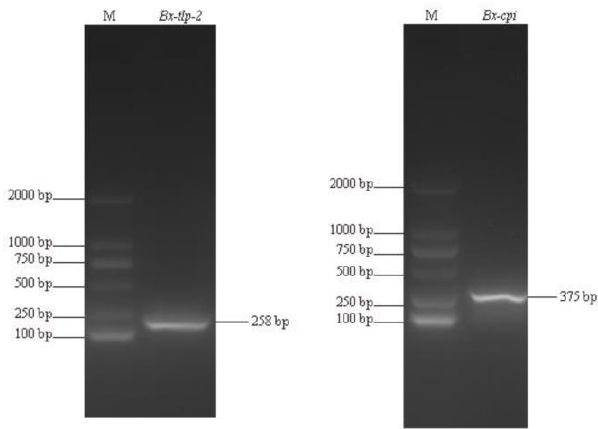
Figure 1. RT-PCR gel electrophoresis detection of Bx-tlp-2 and Bx-cpi. M—DNA ladder.